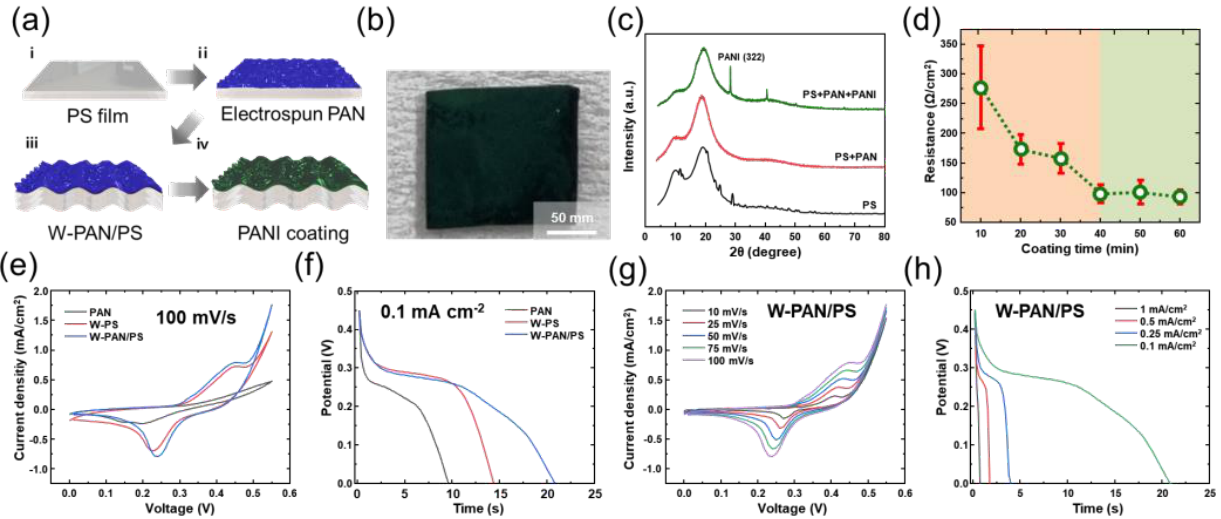
Figure 3. ( a ) Fabrication of wrinkled PANI-coated PS/PAN (W-PAN/PS@PANI) substrate for supercapacitor. ( b ) Photograph of W-PAN/PS@PANI electrode. ( c ) X-ray diffraction (XRD) analysis ( d ) The sheet resistance of PANI with various coating time. ( e ) CV curve measured with scan rate of 100 mV/s. ( f ) GCD curve measured with current density of 0.1 mA/cm 2 . ( g ) CV curves measured at varied scan rates from 10 to 100 mV/s. ( h ) GCD curves measured at varied current densities from 0.1 to 1 mA/cm 2 .